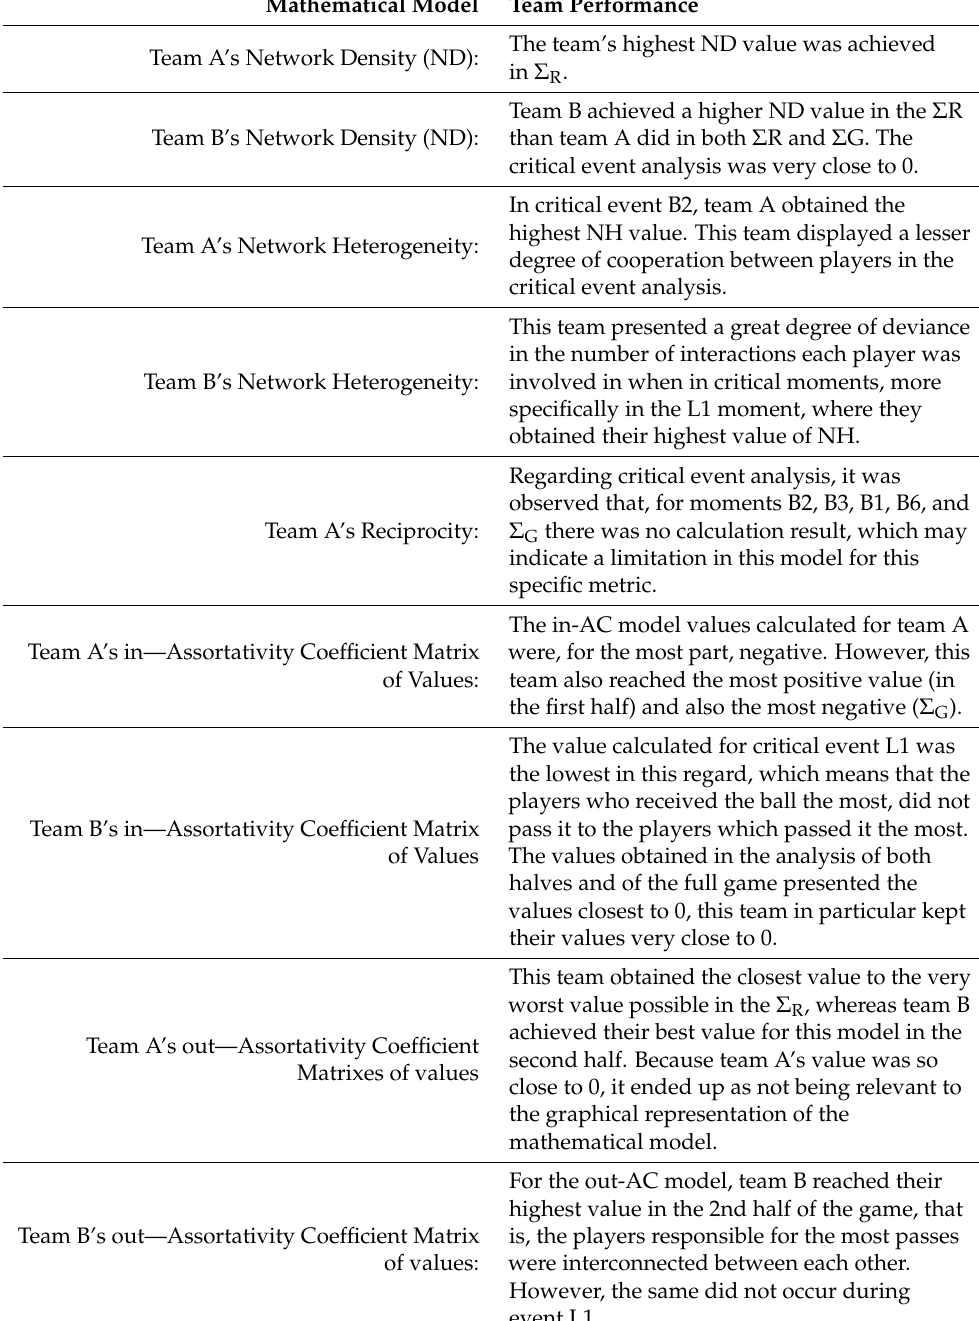
Table 3. Team performance according to each mathematical